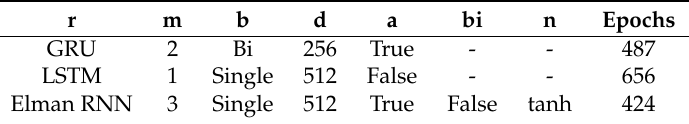
Table 10. RNN model’s parameter tuning